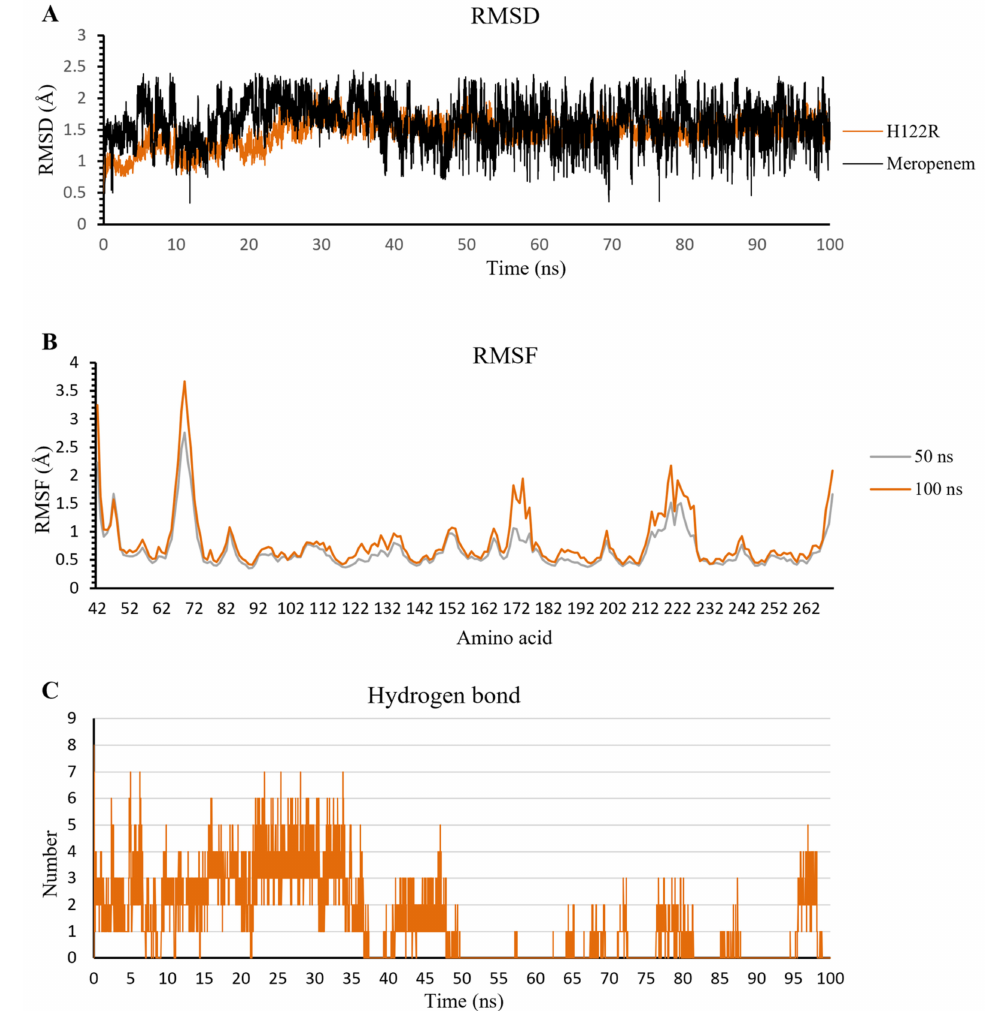
Figure 12. The result of meropenem/H122R complex in 100 ns simulation time. ( A ) The RMSD value of H122R protein and meropenem. ( B ) The RMSF value of 50 ns and 100 ns simulation time. ( C ) The average number of H-bonds formed by meropenem with H122R mutant protein during MD